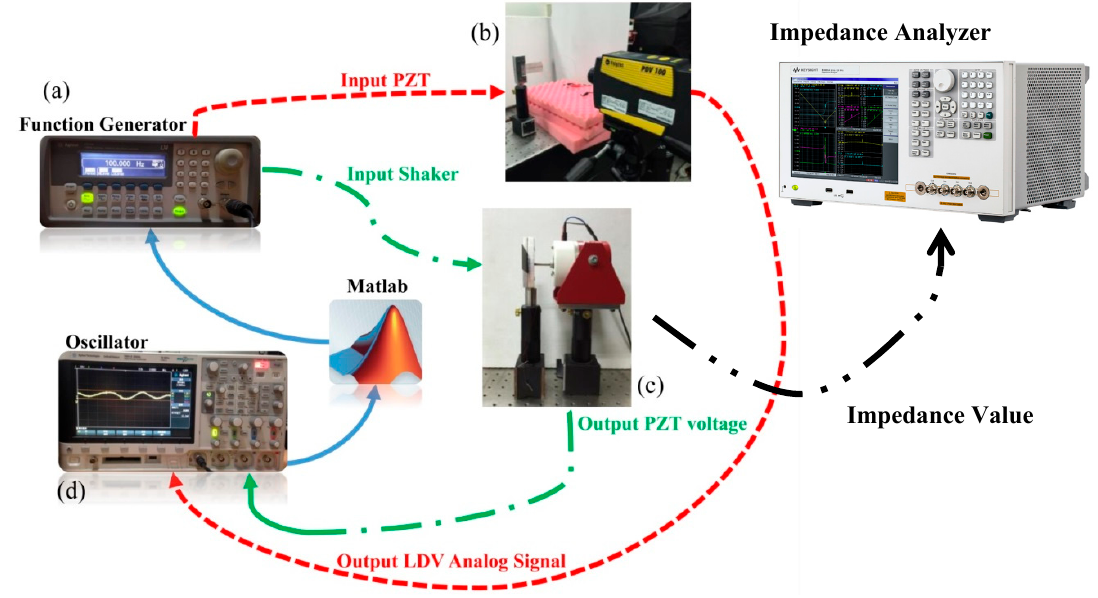
Figure 7. Schematic setup of output voltage under different vibrating frequency.